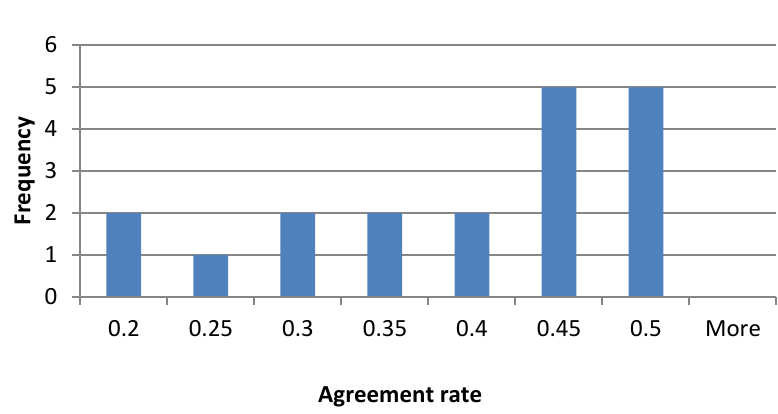
Figure 16. Frequency of mean agreement rate for only those gages that had more than 30 observations and for which the agreement rate was below 50%. Concentration on these provides explanation of model performance. Both the model and in situ data shortcomings are responsible.